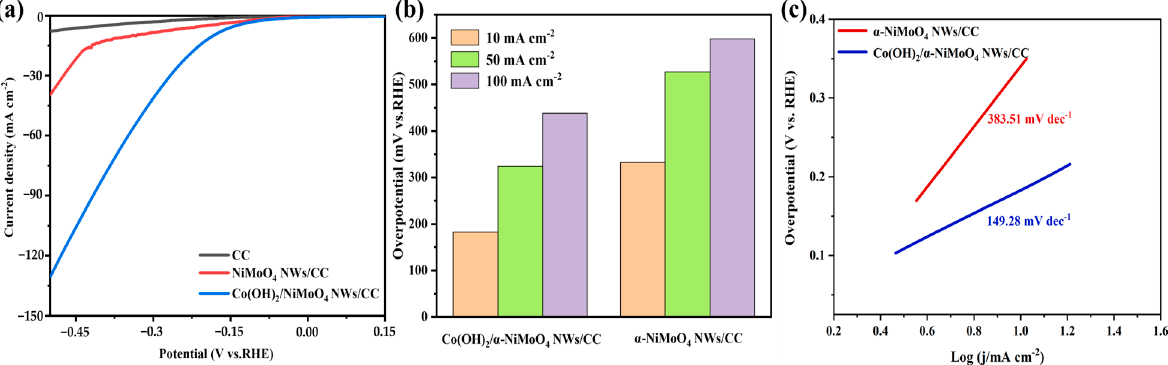
Figure 3. ( a ) LSV curves of different catalysts; ( b ) the overpotential for α‐ NiMoO 4 NWs/CC and Co(OH) 2 / α‐ NiMoO 4 NWs/CC to reach different current densities in a catalytic reaction; ( c ) Tafel curves of α‐ NiMoO 4 NWs/CC and Co(OH) 2 / α‐ NiMoO 4 NWs/CC. The Tafel slope curves were obtained by fitting the LSV curves with the Tafel